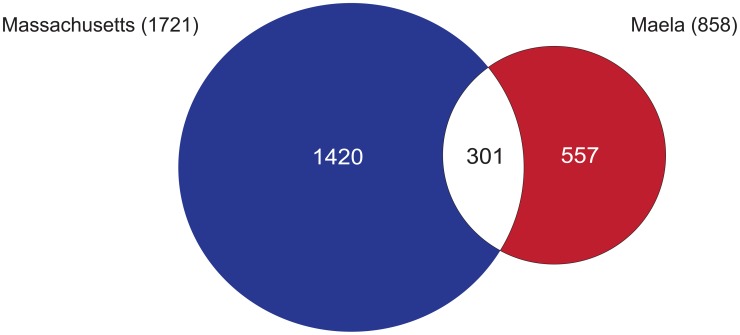
Summary of single nucleotide polymorphisms (SNPs) associated with beta-lactam non-susceptibility.A Venn diagram summarises the number of SNPs reaching significance in each of the Maela and Massachusetts datasets, and those that are co-detected in both.